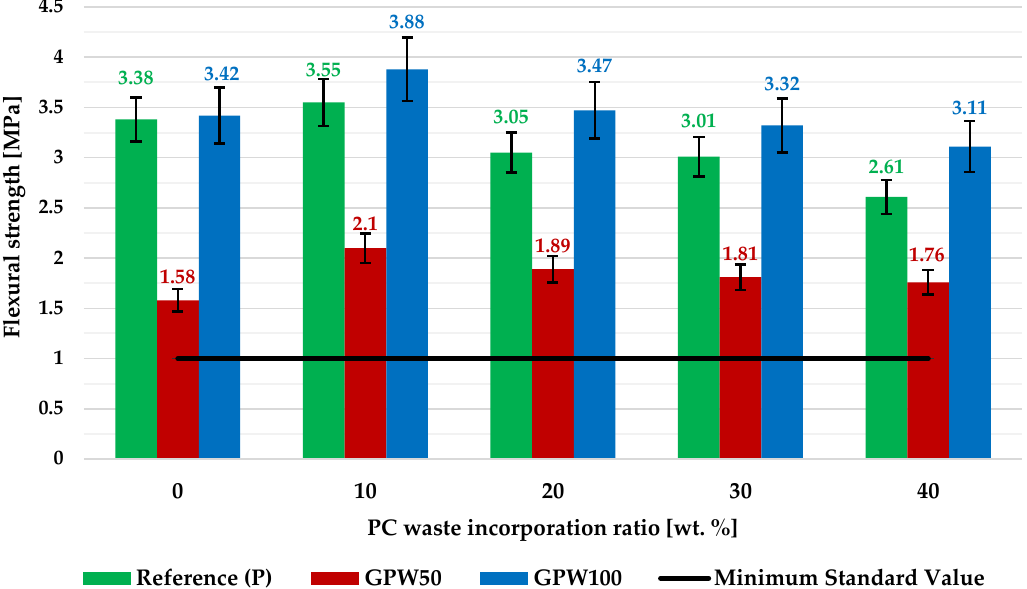
Materials 2020 , 13 , x FOR PEER REVIEW Figure 5. Flexural strength of the developed gypsum plasters with error bars. Figure 5. Flexural strength of the developed gypsum plasters with error bars.